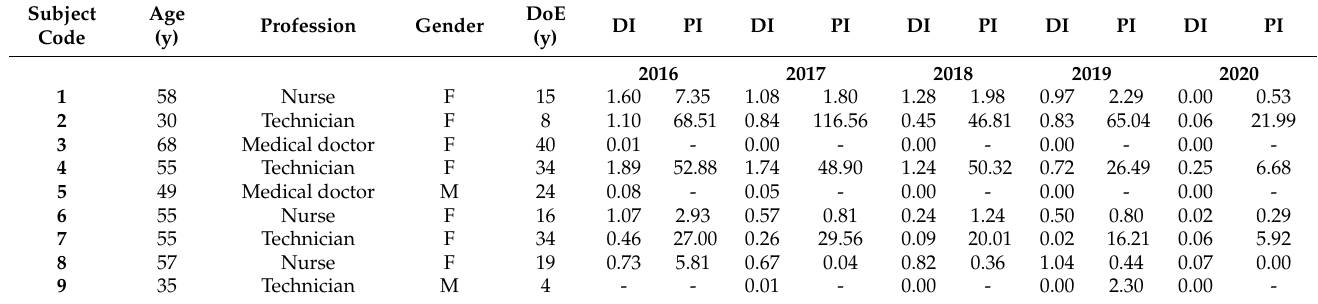
Table 1. Characteristics of the 99m Tc-exposed group, including age, work title, gender, duration of exposure, and dose (mSv) measured by DI and PI for